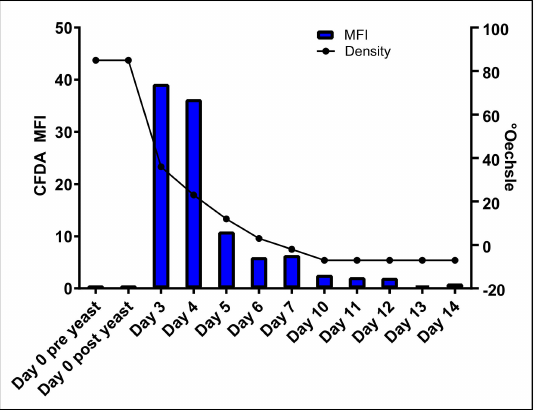
Figure 5. CFDA MFI and density decrease during